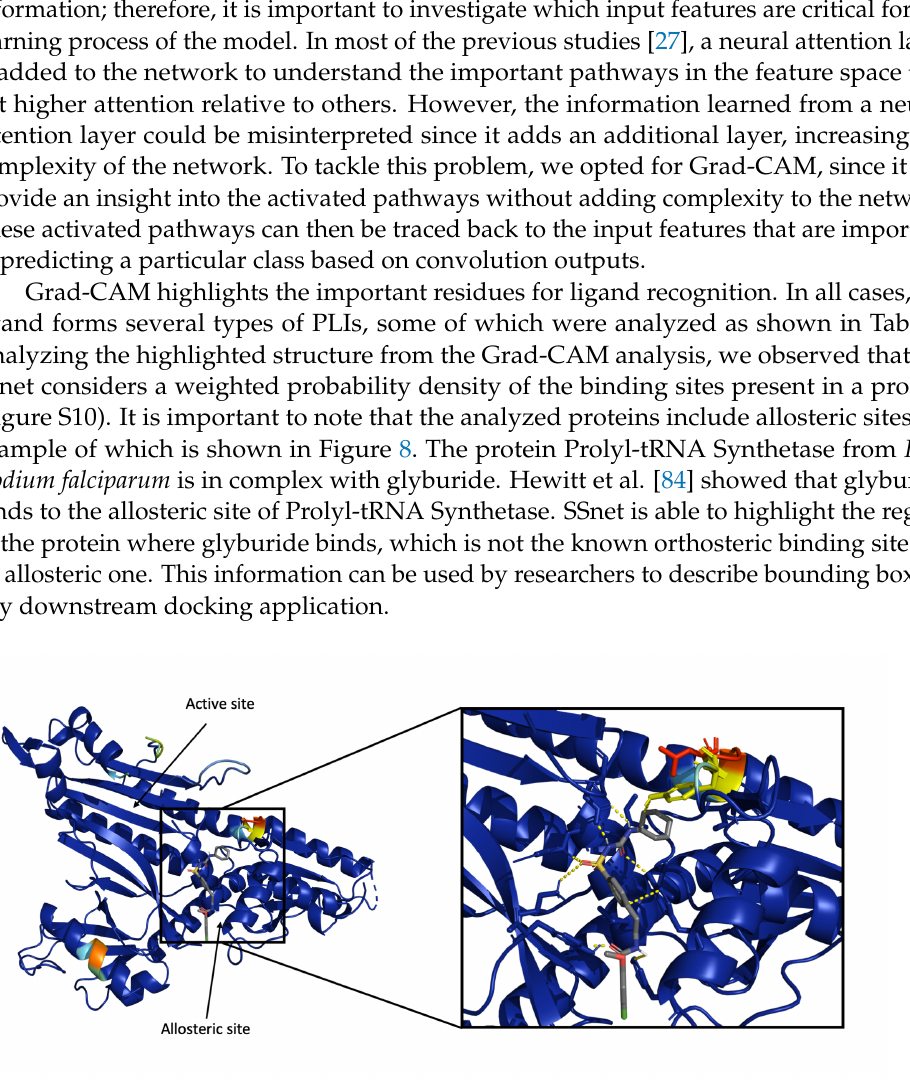
Figure 8. Grad-CAM visualization of heatmap for the protein Prolyl-tRNA Synthetase. The heatmap is a rainbow mapping with violet as the lowest and red as the highest value. Table 7. Percentage of detected residues by